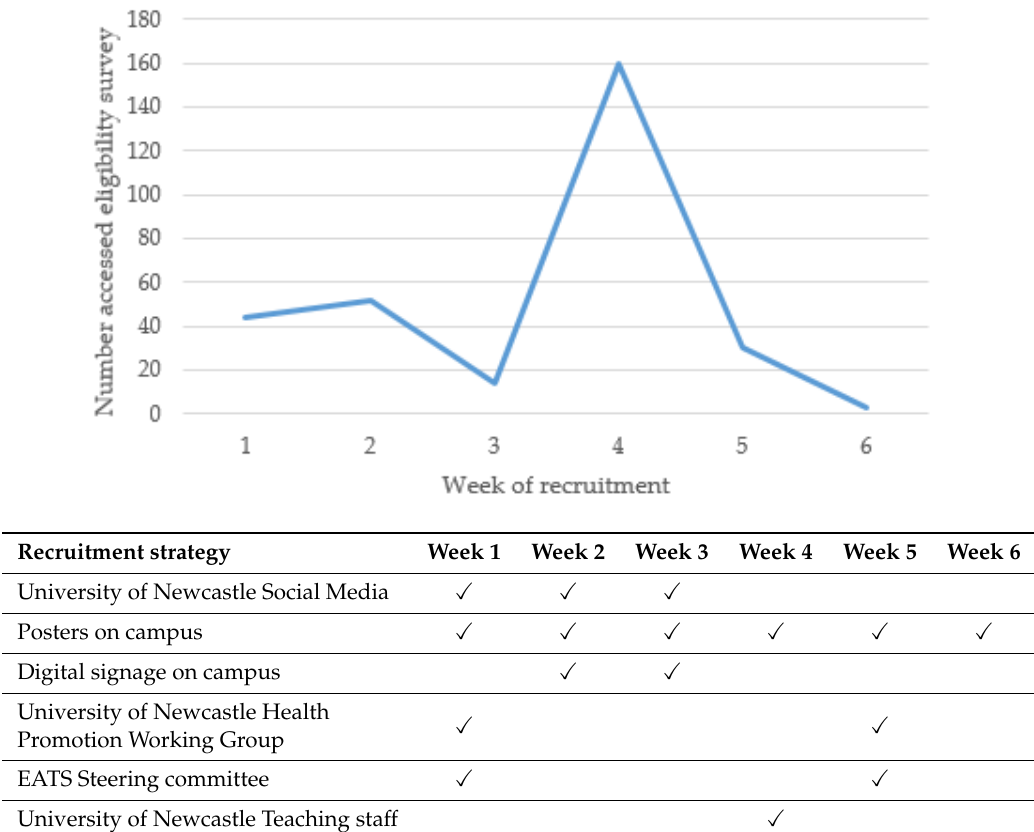
Figure 2. Number of individuals interested in participating in the EATS pilot randomized controlled trial according to recruitment week and recruitment strategies used.